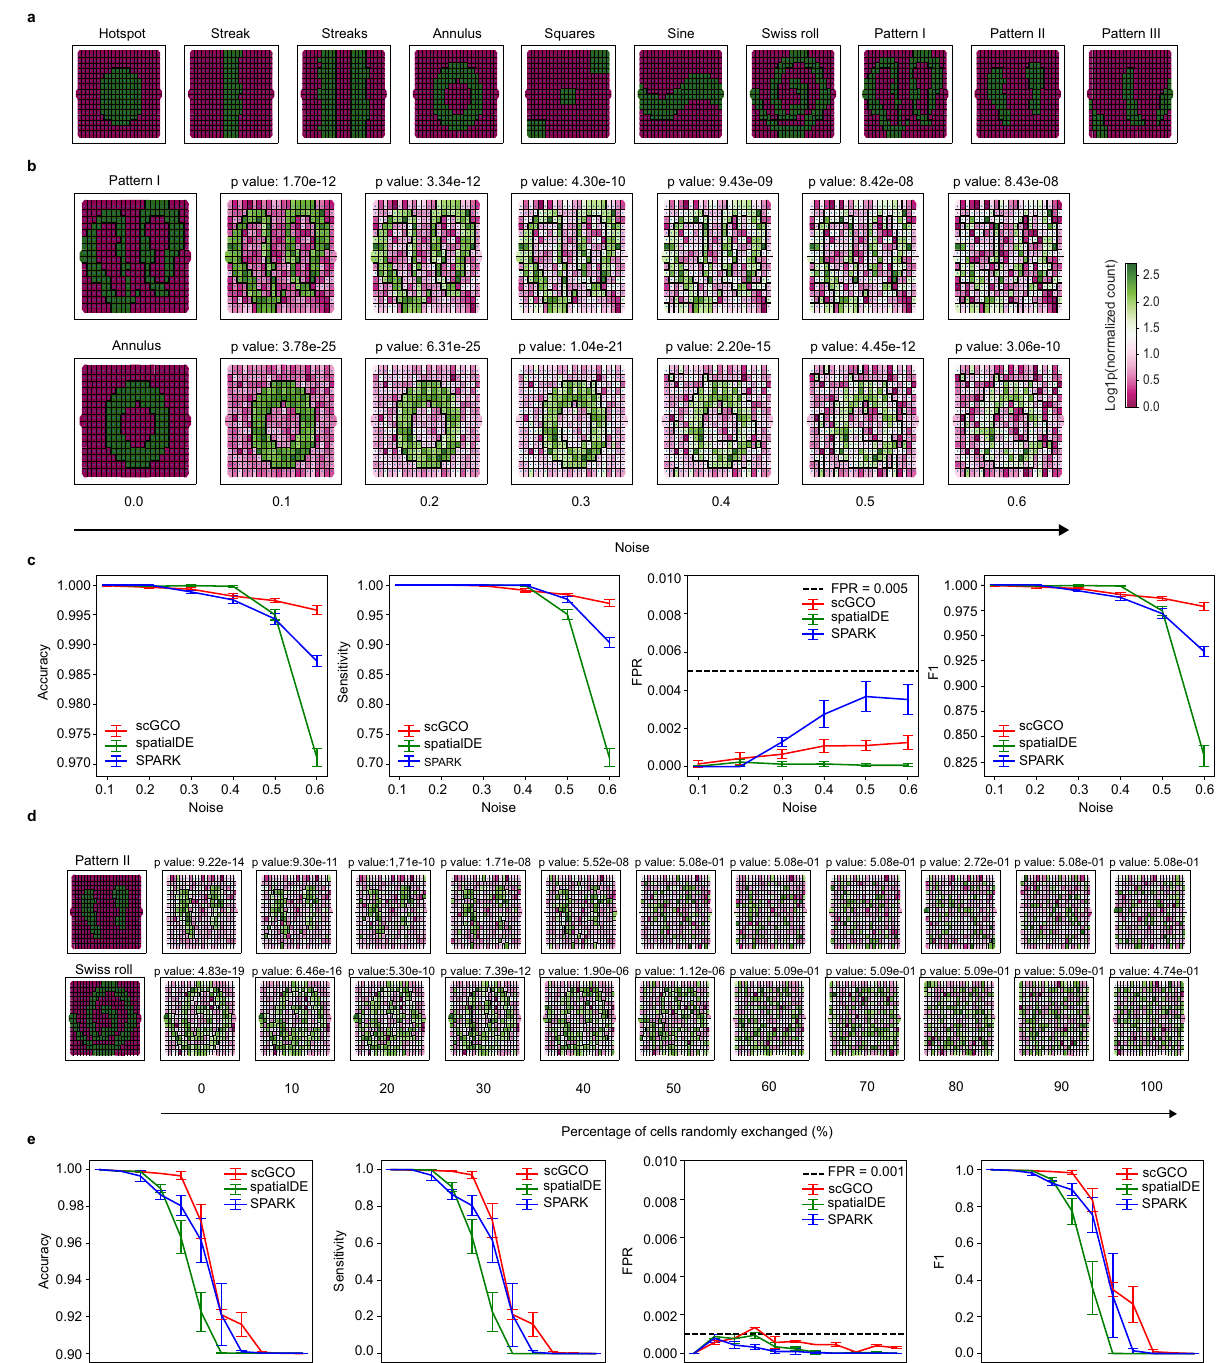
Fig.2|PerformanceofSVgeneidenti fi cationalgorithmsusingsimulateddata. a The ten spatial patterns utilized in our simulation. b Representative graph cuts results at increasing Gaussian noise levels for scGCO. P -values were calculated by scGCO without multiple-testing correction. c Line plots showing accuracy, sensi- tivity, false positive rate (FPR) and F1 score for SPARK, spatialDE, and scGCO with increasing Gaussian noises. Plots were generated from n =10 independent simu- lations at each noise level. Error bars indicate the means±SD. d Representative